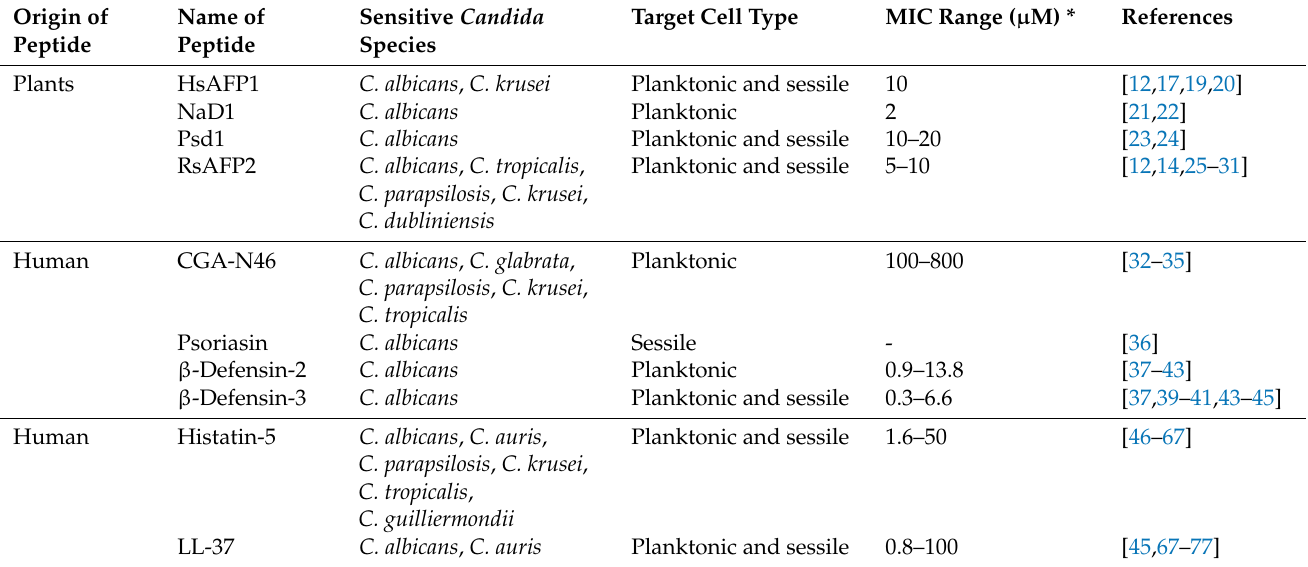
Table 2. Effectivity of the peptides against planktonic and/or sessile cells of Candida